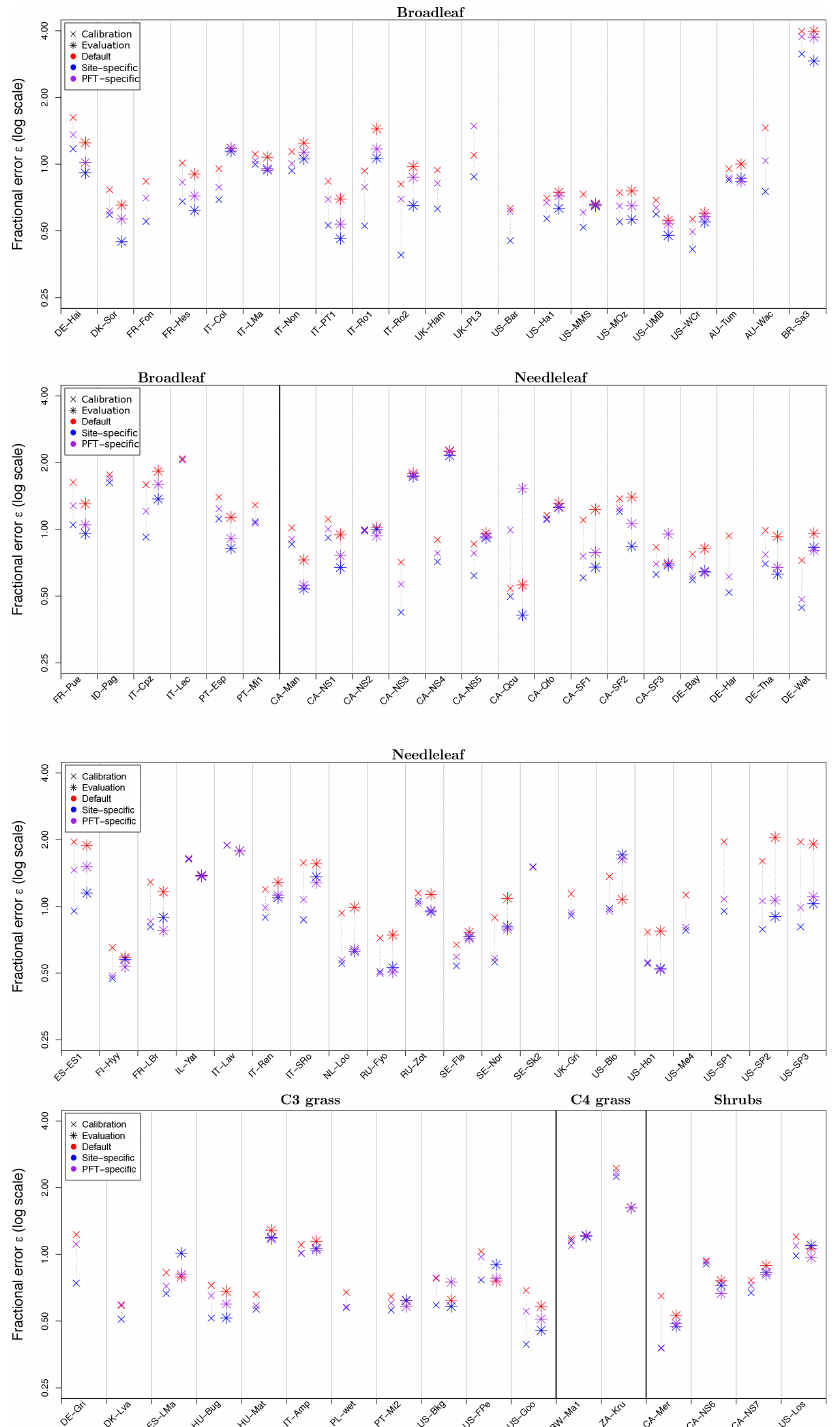
Figure 5. Calibration and evaluation of site-specific and PFT-specific parameter optimisation at FLUXNET sites, using the metric described in Sect. 2.5.2. Fractional error shown for default JULES parameters (red), site-specific optimal parameters (blue), PFT-specific optimal parameters (violet). Results are shown both for the calibration year ( × , on left) and for the evaluation year ( ∗ , on right). No evaluation year was available for some sites (broadleaf: FR-Fon, UK-Ham, UK-PL3, US-Bar, ID-Pag, IT-Lec, PT-Mi1; needleleaf: SE-Sk2, UK-Gri, US- Me4, US-SP1; shrubs: DE-Gri, DK-Lva, PL-wet). Sites with very large initial errors have been removed from the plot (broadleaf: BR-Sa1; shrubs: